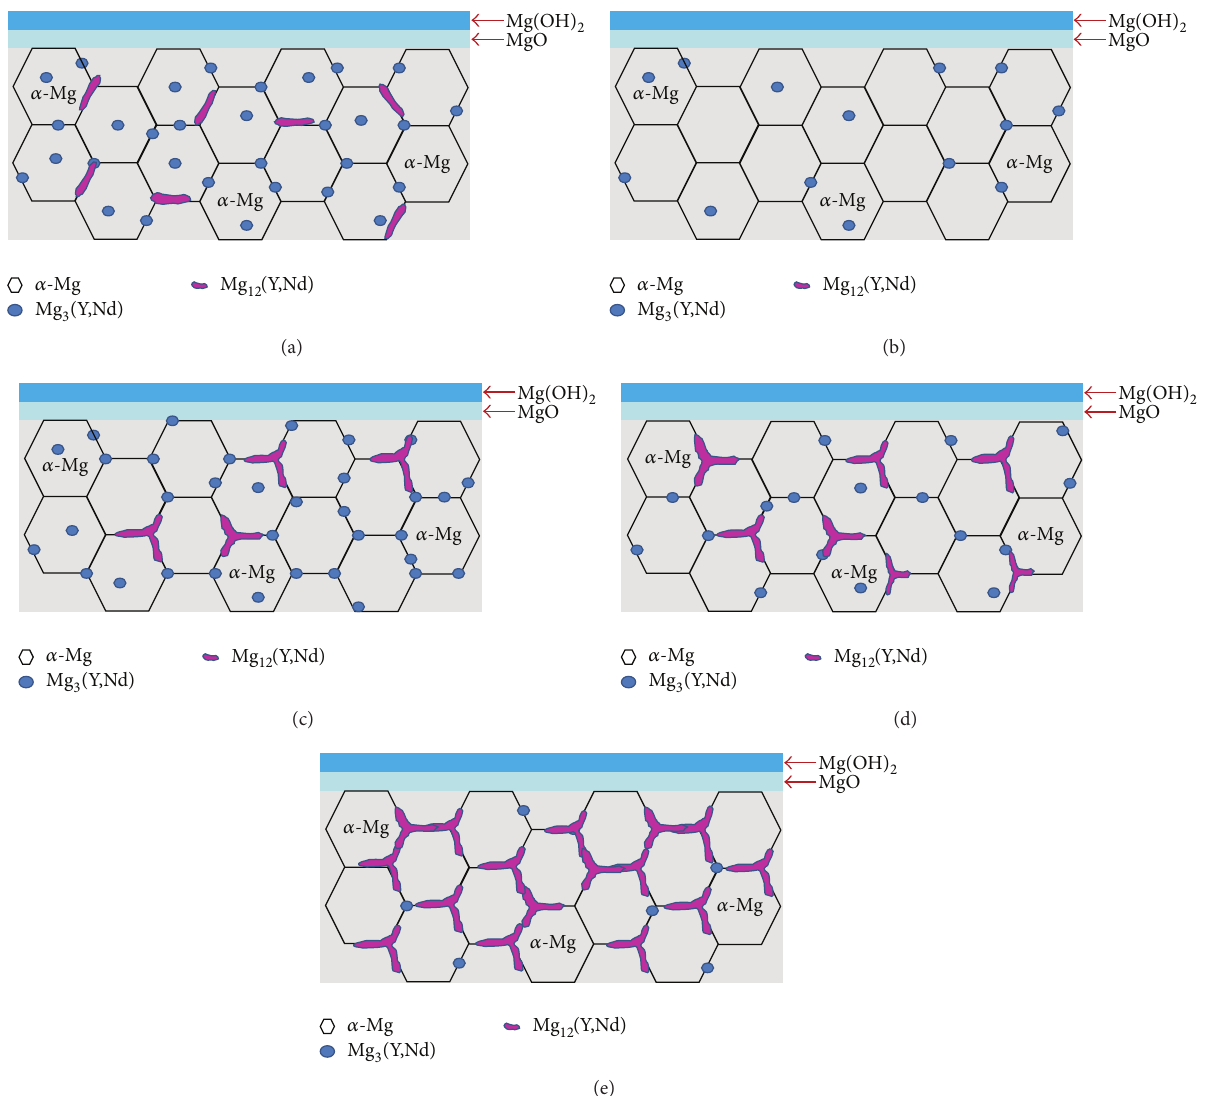
Figure 8: The schematic diagram of microstructure related to the corrosion mechanism: (a) as-cast, (b) T4, (c) T6-6h, (d) T6-14h, and (e)